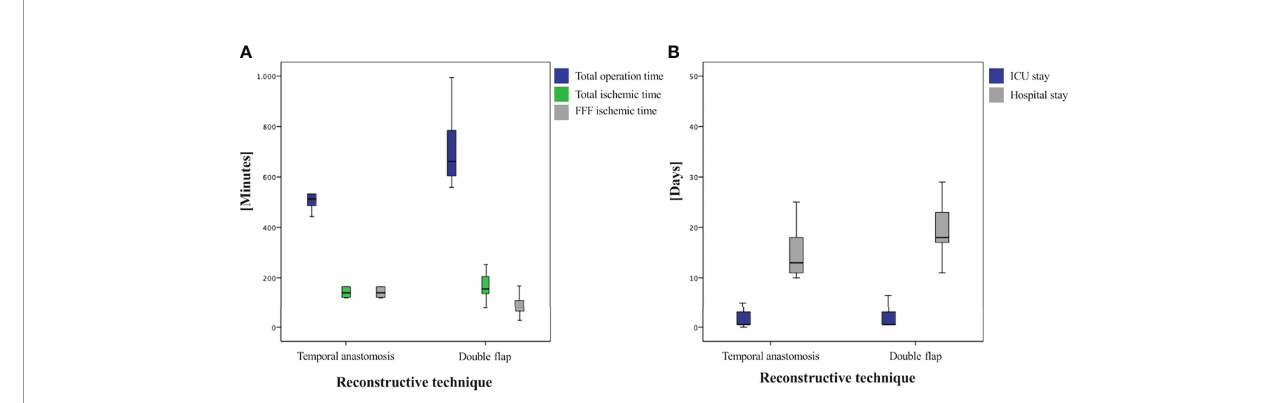
FIGURE 3 | Boxplots of analyzed times: (A) comparison of operation-speci fi c times and (B) comparison of ICU and total hospital